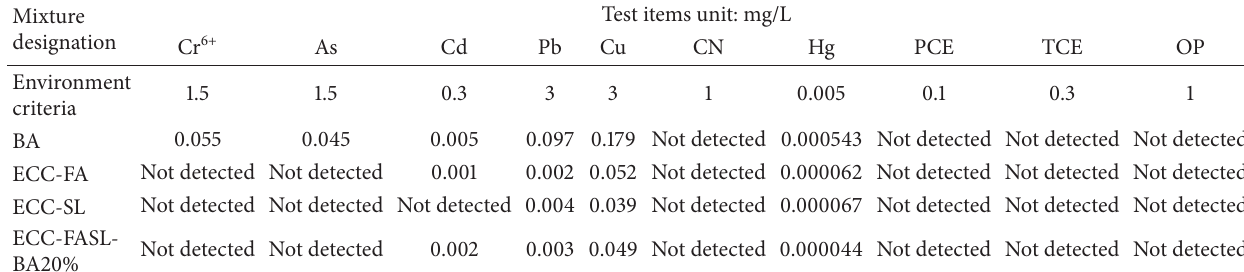
Figure 3: Slump flow behavior of ECC. Table 5: Environment criteria and detection amount of harmful materials by solid waste management